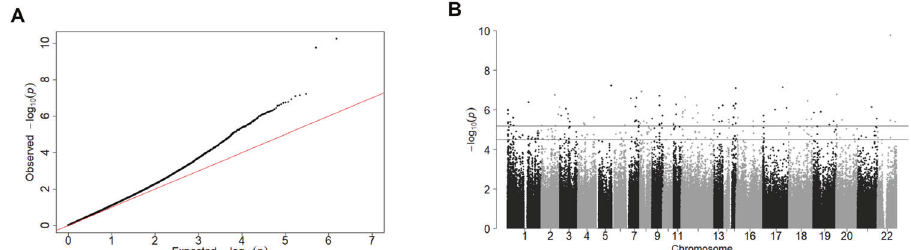
Fig. 1 SZ-associated differential methylation. A Probability plot showing that the analysis for sites at which DNAm differed between SZ and NPC subjects is enriched in small p values compared to what would be expected by chance. The y = x line represents the distribution of p values that would be expected by chance. B Manhattan plot showing that the DNAm differed between subjects with SZ and NPC subjects at many DNAm sites, and the sites were distributed across many autosomes. The horizontal lines represent FDR cutoff of q = 0.1 (bottom) and q = 0.05 (top). DNAm DNA methylation, SZ schizophrenia, NPC non-psychiatric comparison, FDR false discovery